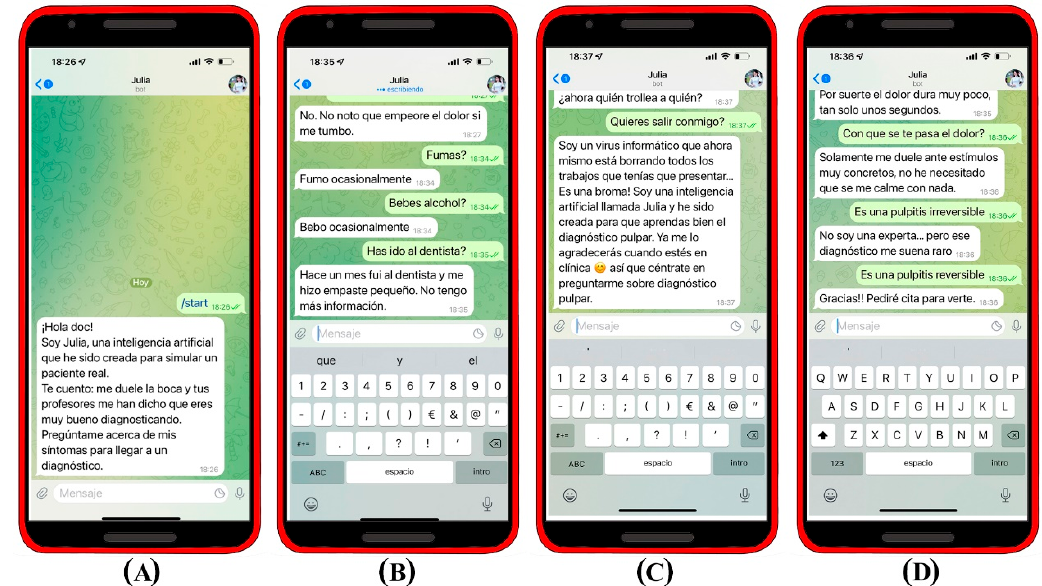
Figure 4. Example of a conversation flow. ( A ) At the beginning of the interaction with Julia, she introduces herself and makes directions about what the student should do. ( B ) Julia is able to answer different questions about the current condition. ( C ) Colloquial responses to intimate questions that were unrelated to the case were established in order to arouse students’ curiosity and redirect them. ( D ) In case of reaching an incorrect diagnosis, Julia redirects the student.